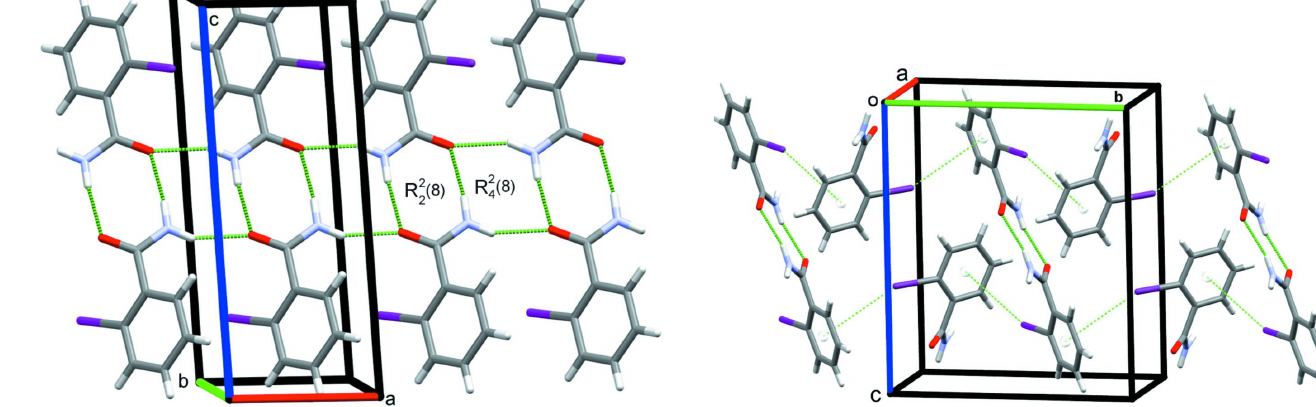
Figure 4 N—H (cid:2)(cid:2)(cid:2) O and C—I (cid:2)(cid:2)(cid:2) (cid:2) (ring) contacts forming sheets of molecules of (I) in the bc